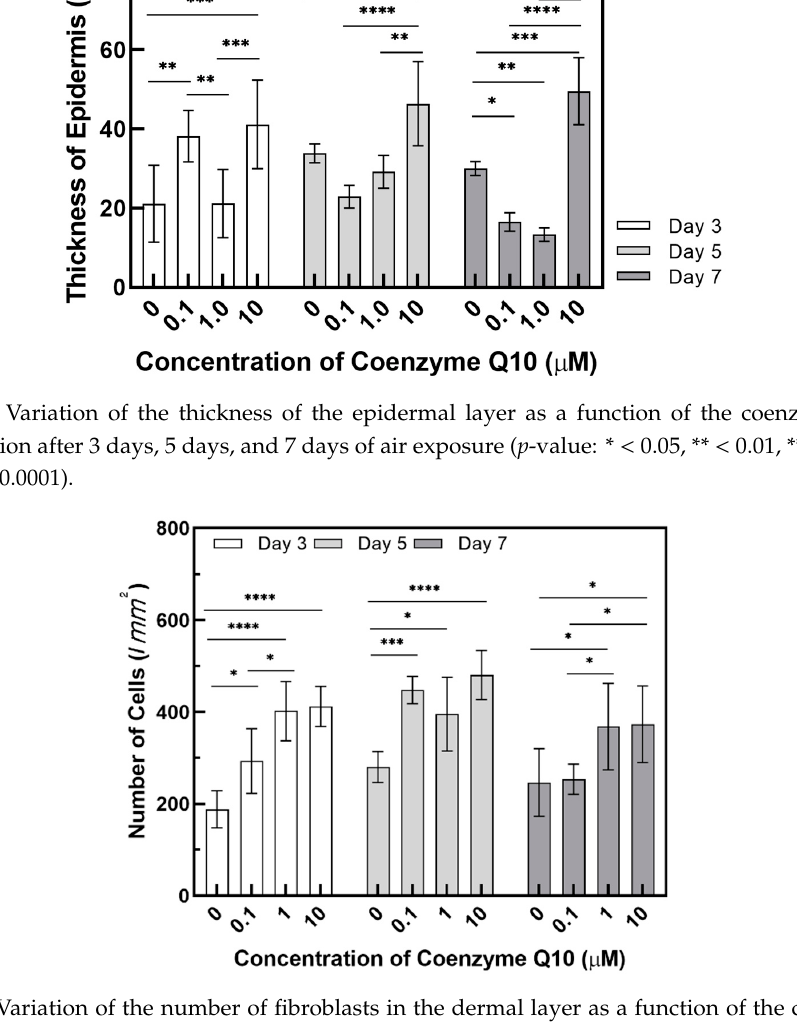
Figure 7. Variation of the number of fibroblasts in the dermal layer as a function of the coenzyme Q10 concentration after 3 days, 5 days, and 7 days of air exposure ( p -value: * < 0.05, *** < 0.001, and **** < 0.0001).